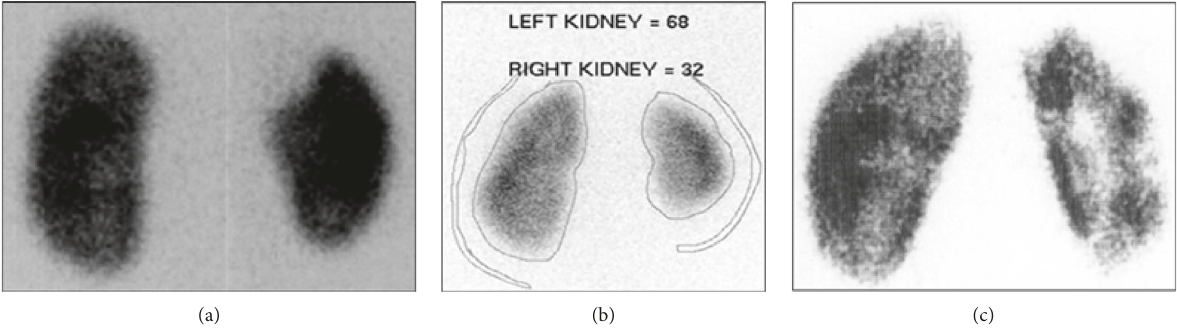
Figure 2: (a) DMSA scan image reveals a cold spot in the upper pole of the right kidney due to renal scarring in a child with a history of febrile urinary tract infections. (b) DMSA scan image reveals left multiple cold spots in the right kidney due to multiple renal scarring after recurrent urinary tract infections. (c) DMSA scan image reveals global atrophy of the right kidney due to grade V severe vesicoureteral reflux.